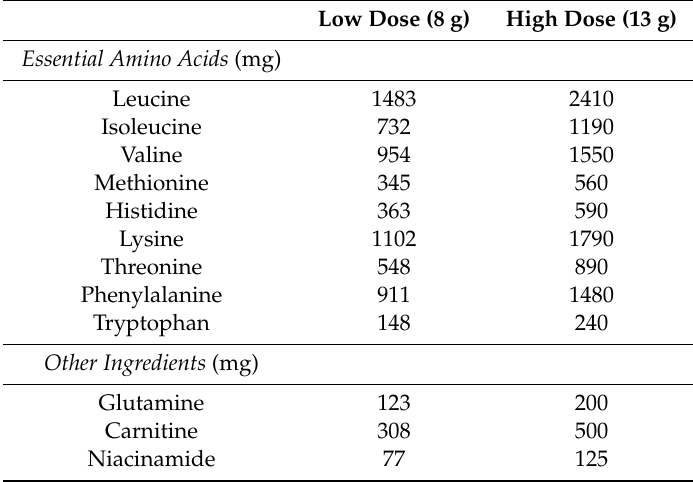
Table 1. Essential amino acid supplement (EAAS)